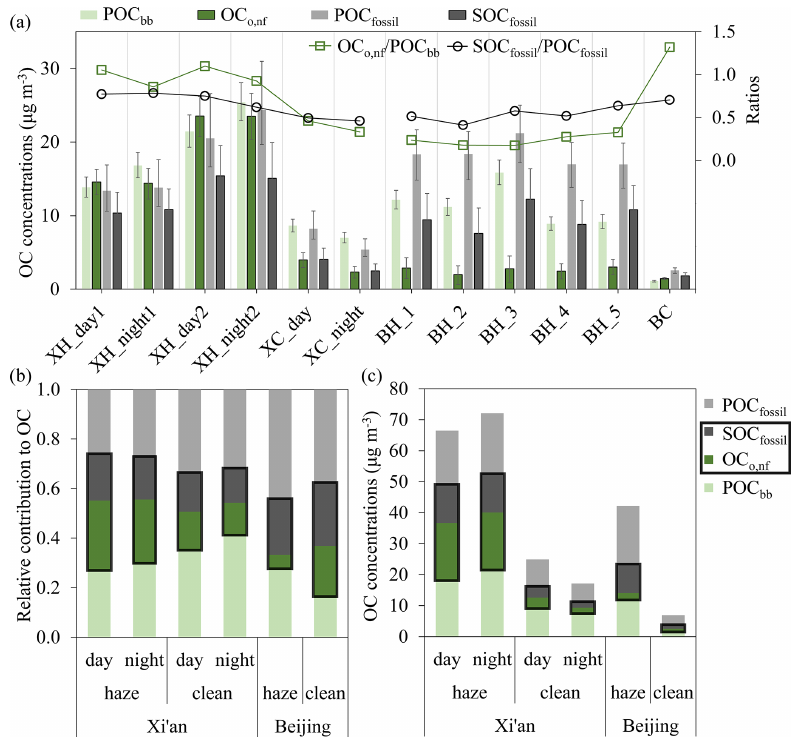
Figure 5. (a) Concentrations of POC bb , OC o,nf , POC fossil , and SOC fossil (µgm − 3 ) and the mass ratio of OC o,nf / POC bb and SOC fossil / POC fossil of each sample. The error bars indicate the interquartile range (25th–75th percentile) of the median concentrations. Averaged fractions (b) and concentrations (c) of POC bb , OC o,nf , POC fossil , and SOC fossil in total OC during haze and clean periods in Xi’an and Beijing, China. The data are given in Table S4.